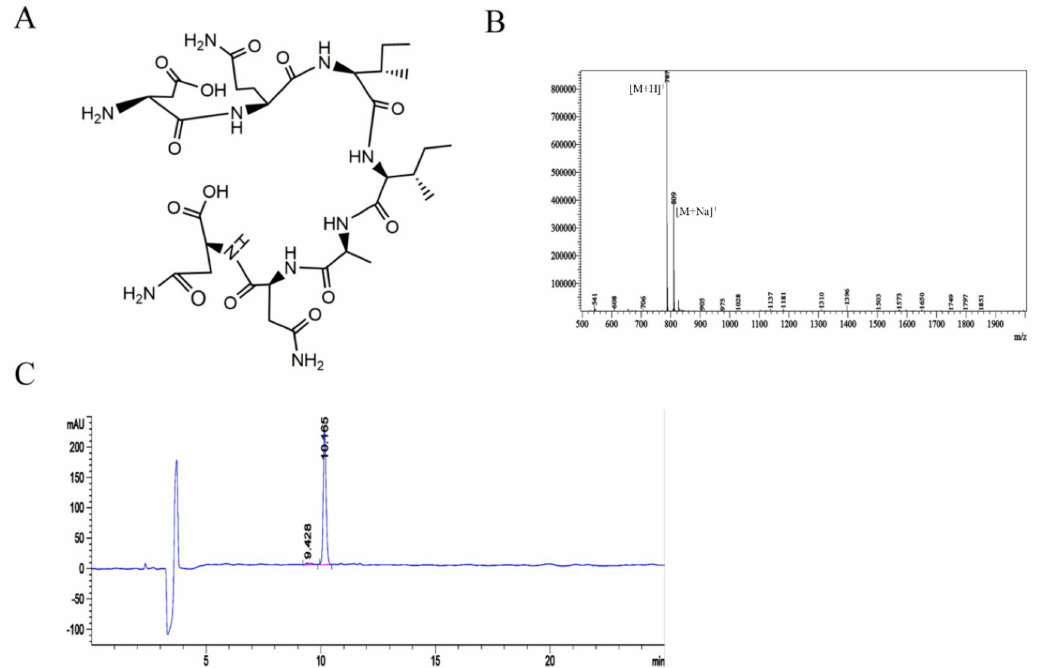
Figure 2. The chemical structure, molecular mass, and purity of peptide CM 7. ( A ) Chemical structure of peptide CM 7. ( B ) Electrospray ionization mass spectrometry (ESI-MS) showed that the molecular mass of peptide CM 7 was 786. ( C ) The purity of peptide CM 7 was determined by high-performance liquid chromatography (HPLC) to be